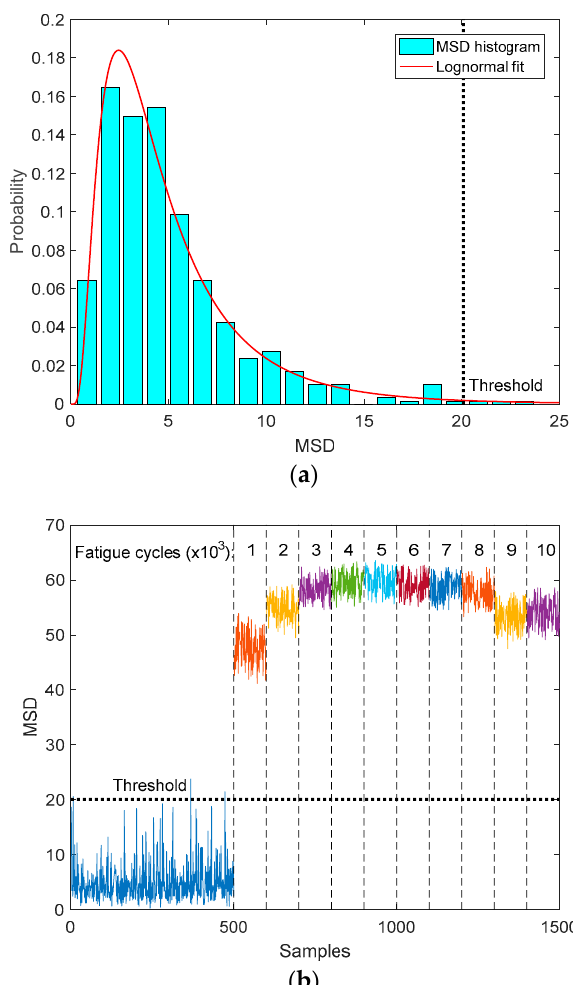
Figure 12. Outlier analysis results for specimen S_B with Level 2 contamination: ( a ) PDF of baseline MSD and ( b ) MSDs for different fatigue states.